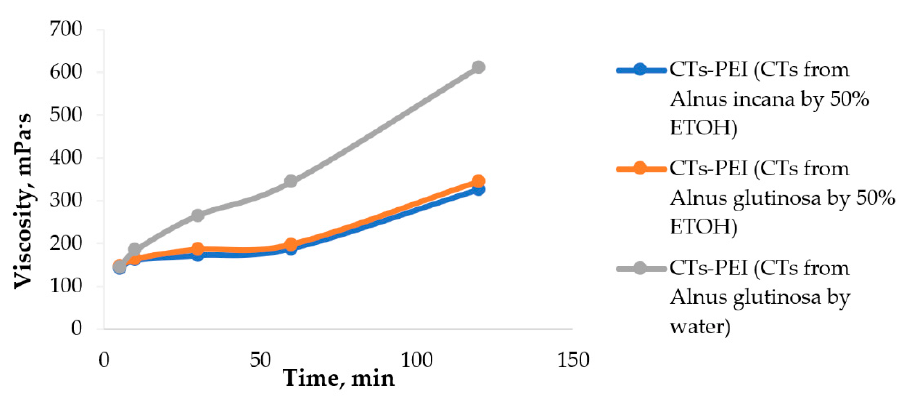
Figure 9. The viscosity of CTs–PEI adhesive depending on time, at 25